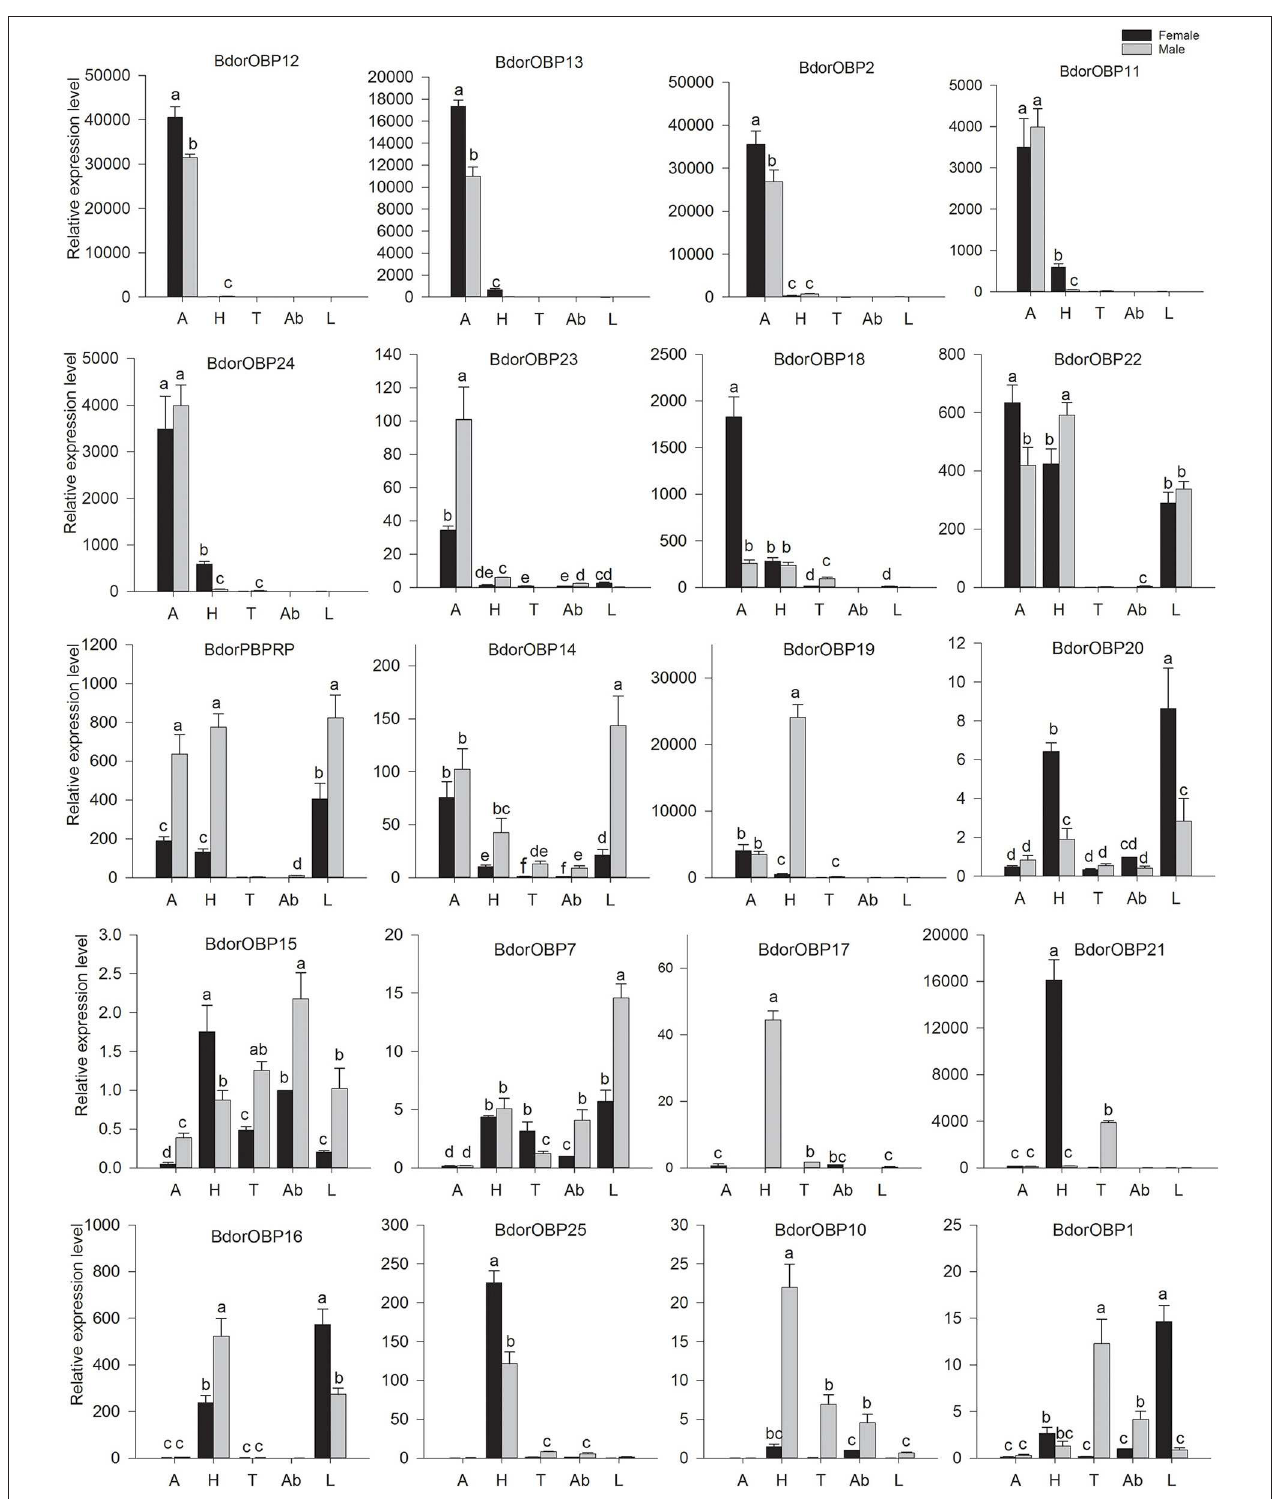
FIGURE 3 | Expression profile of B. dorsalis OBPs in different tissues. Total RNA was separately extracted from both male and female antennae (A), heads (H), thoraxes (T), abdomens (Ab), and legs (L). The black rectangles show the expression level of the OBPs in male tissues, and the gray rectangles show the expression level of the OBPs in female tissues. The bars represent mean ± standard deviation (SD), and the letters indicate statistically significant differences between the groups (Tukey’s honest significant difference test).